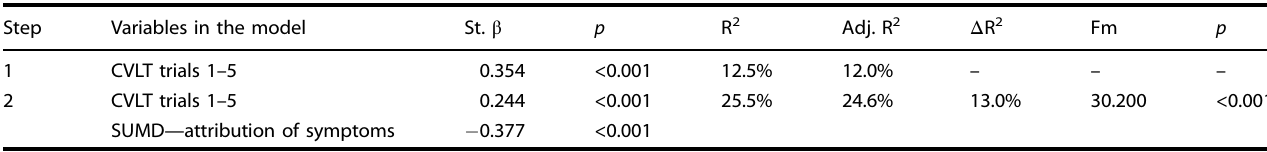
Table 4. Relative contribution of neurocognition and insight to intrinsic motivation: second hierarchical regression analysis ( n =